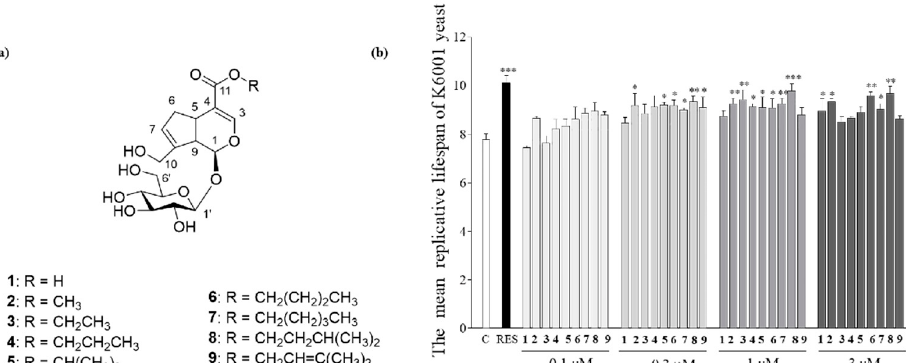
Figure 1. The chemical structure and effect of 1 – 9 on the replicative lifespan of yeasts. ( a ) The structure of 1 – 9 . ( b ) The K6001 yeast replicative lifespan of 1 – 9 . C represents negative control, RES represents positive control (10 µ M). Experiments were repeated thrice, and the data are presented as means ± SEM. * p < 0.05, ** p < 0.01, and *** p < 0.001 represent significant difference compared with the control group.